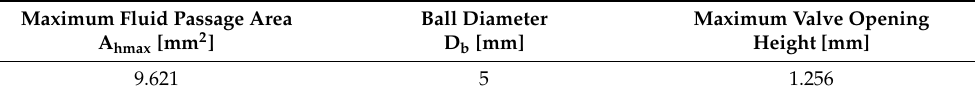
Table 3. Maximum theoretical opening height (x) of the valve ball.